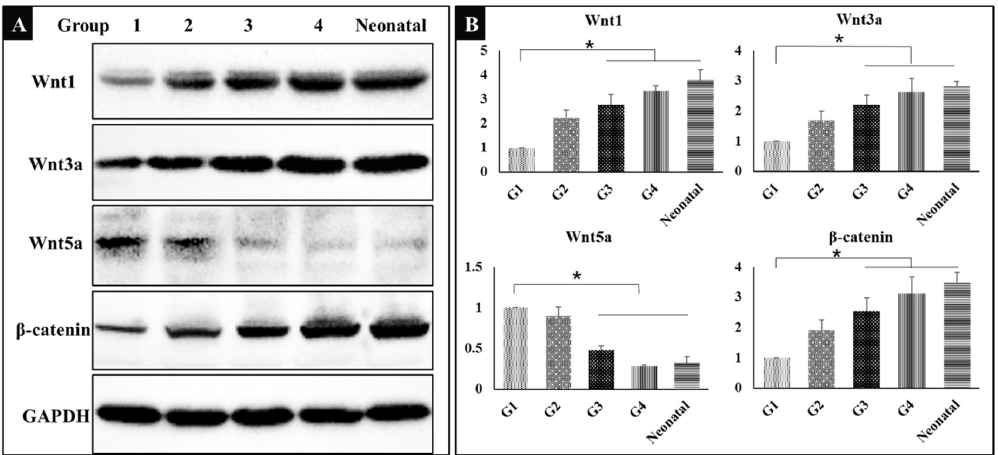
Figure 5. ( A ) Western blot showing the expression of wingless/integrated 1 (Wnt1), Wnt3a, Wnt5a, β- catenin, and glyceraldehyde-3-phosphate dehydrogenase (GAPDH) in five groups ( n = 3). G1: negative control group; G2: running group; G3: weight-bearing group; G4: positive control group; Neonatal: the neonatal bone, control. ( B ) The corresponding gray-scale value of Wnt1, Wnt3a, Wnt5a and β-catenin in the five groups ( n = 3); comparison among G1 and other three groups (G3, G4, and Neonatal), * P < 0.05. Metabolites 2020 , 10 , x FOR PEER REVIEW